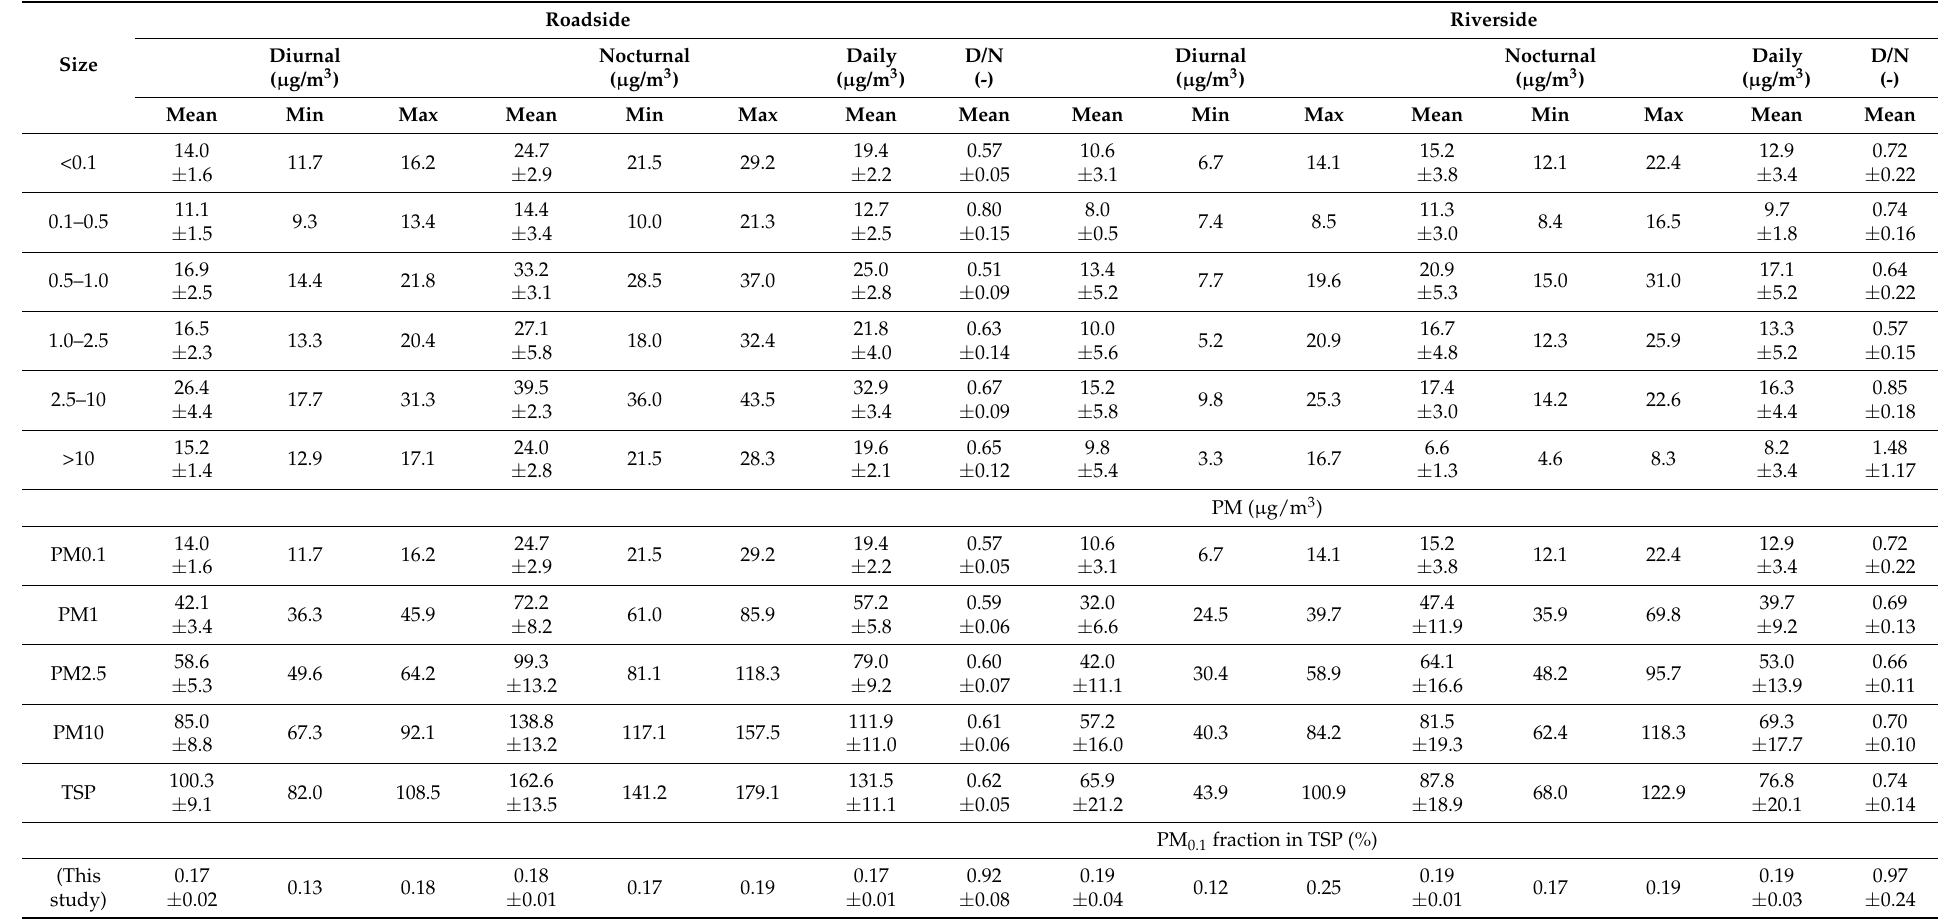
Table 1. The daily mean, minimum, and maximum of size-segregated PMs in roadside and riverside, Jambi City,